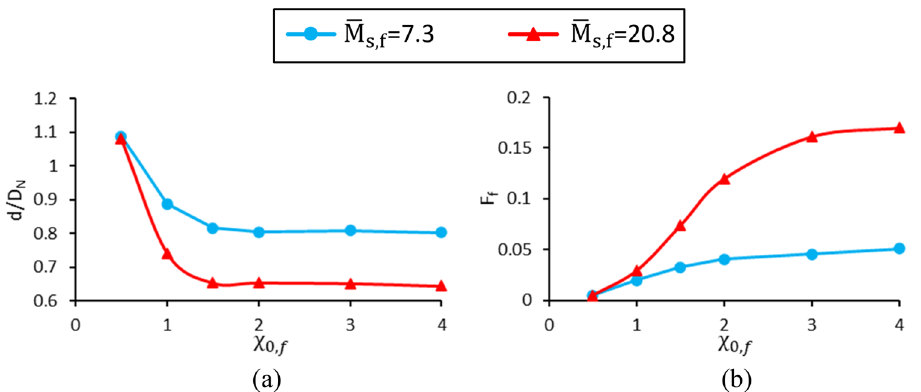
10 and ( b ) L 20 . D N = N =